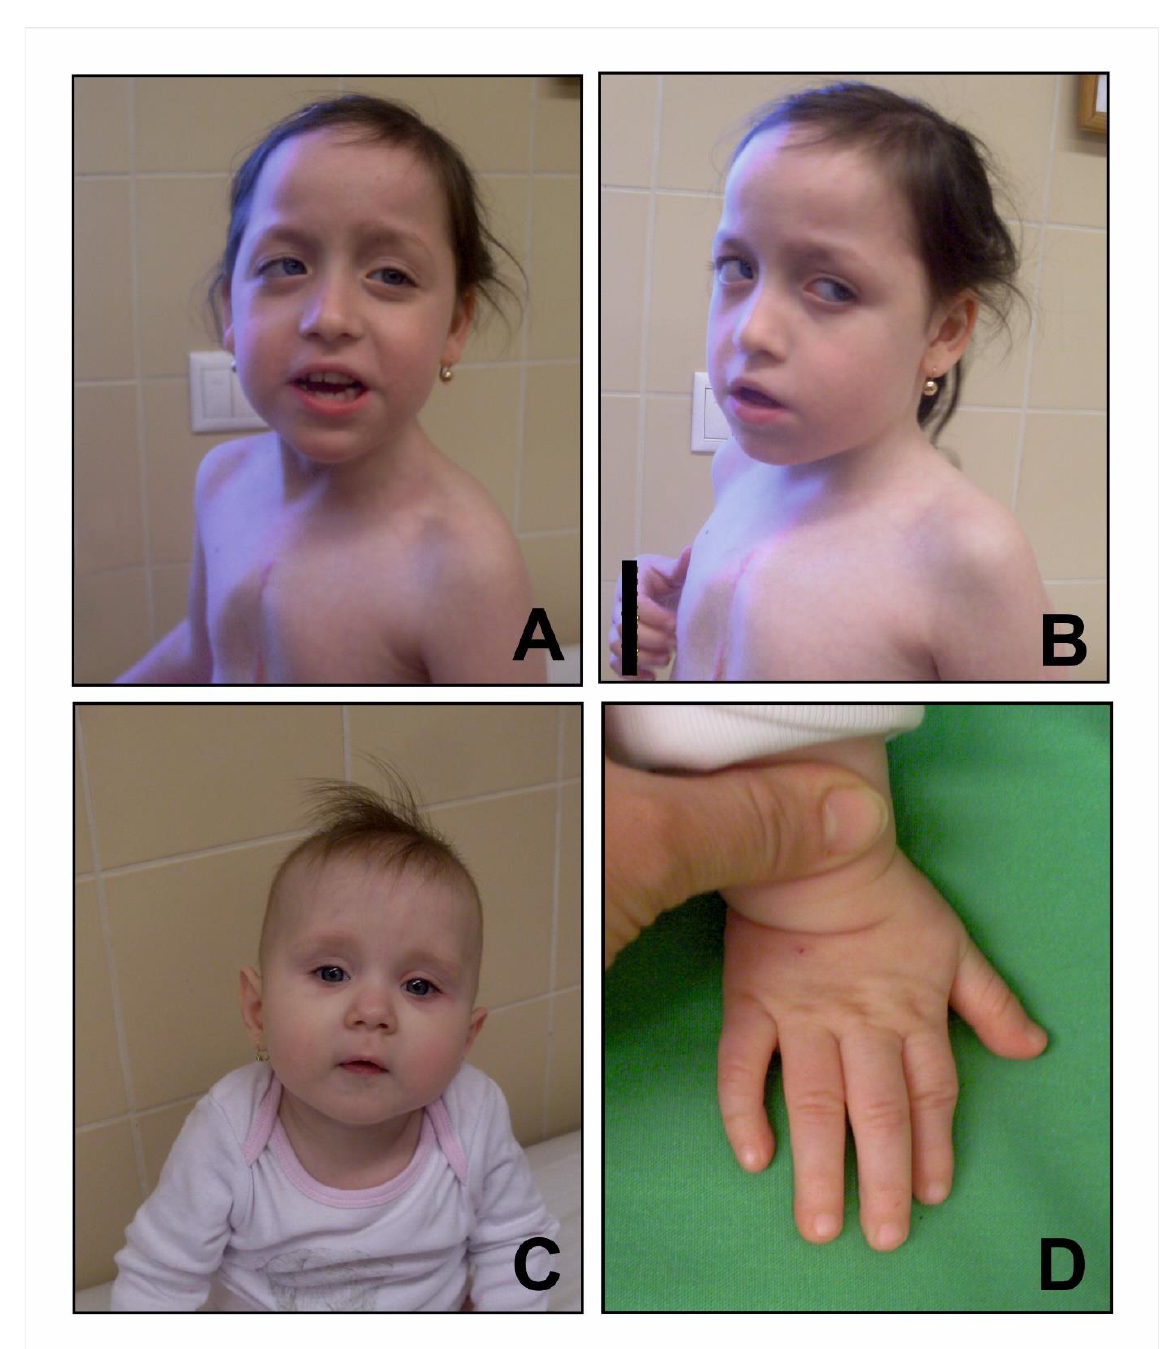
Figure 1. Photographs of patient with pathogenic ADNP variants. Note thin, straight, sparse hair; light skin colour; ptosis; high anterior and posterior hairline in both patients ( A – C ); long and antimongoloid palpebral fissures; strabismus; peculiar upward gaze; low-hanging, everted lower eyelids; an evenly thick helix bilaterally; superior pectus carinatum; inferior pectus excavatum and the scar of previous cardiac surgeries in Patient 1 ( A , B ). Round face; horizontal palpebral fissures; ptosis; long philtrum; small mouth; thin upper lip; apparent hypotonia ( C ); 5th finger clinodactyly and prominent distal interphalangeal joint of the 2nd finger ( D ) can be seen in Patient 2.